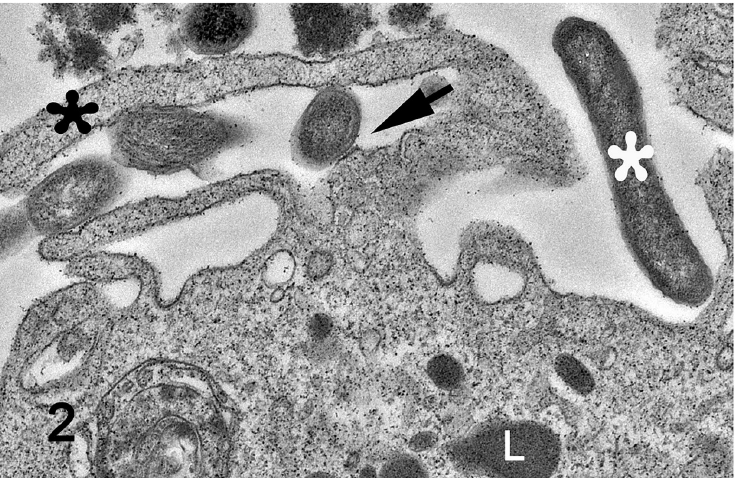
Fig 2. Monocyte-derived macrophage infected with Lawsonia intracellularis . Transmission electron microscopy. Cross-sectioned L . intracellularis was attached to the macrophage surface, where an electrodense interface between bacteria and macrophage plasmamembrane is observed (black arrow), adjacent to formation of a phyllopod (black asterisk) at one-hour post infection. L . intracellularis in longitudinal section (white asterisk) is also observed in the proximity of the macrophage surface. L: